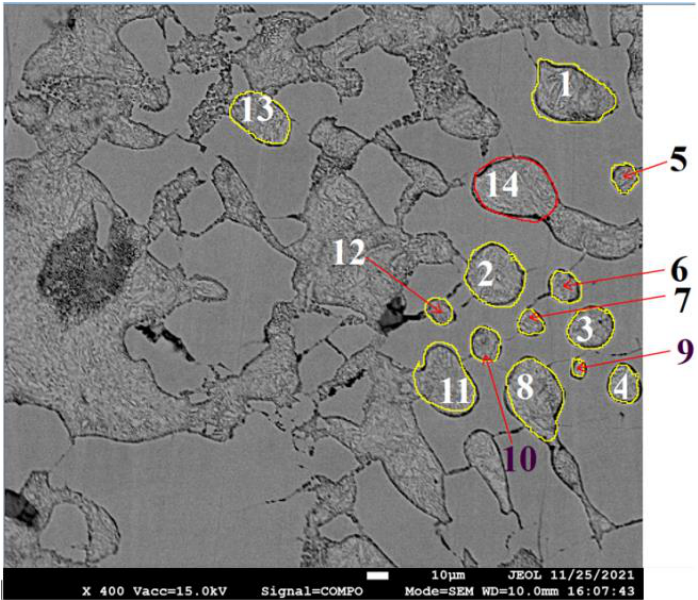
Figure 16. Analyzing the shape and determining the areas of pearlite colonies in the structure of sample 1 using the Thixomet image analyzer, ×400. A positive role in improving the impact resistance of samples 1 and 3 is played by the components (Figure